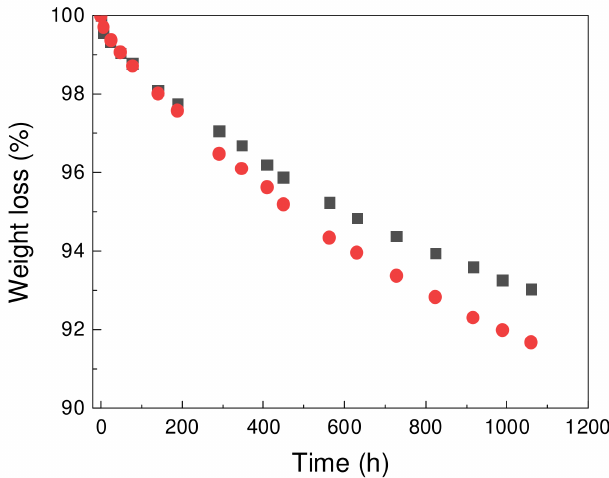
Figure 4. Weight loss of PW1 (squares) and PW05 (circles) samples over time.